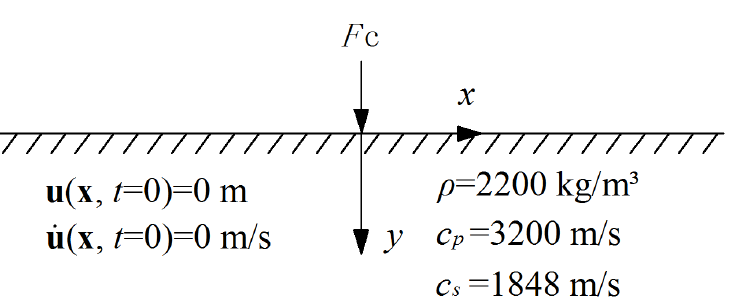
Figure 3. The Lamb’s problem.